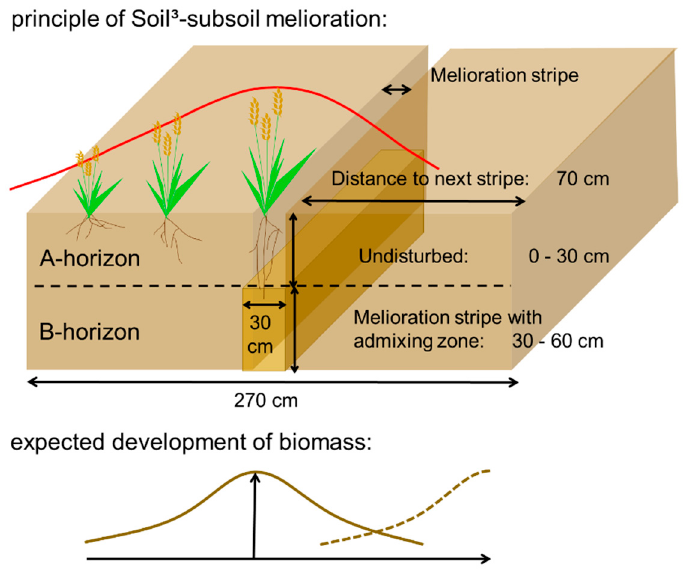
Figure 1. Soil 3 subsoil melioration principle and the expected Gaussian biomass distribution above the stripe.